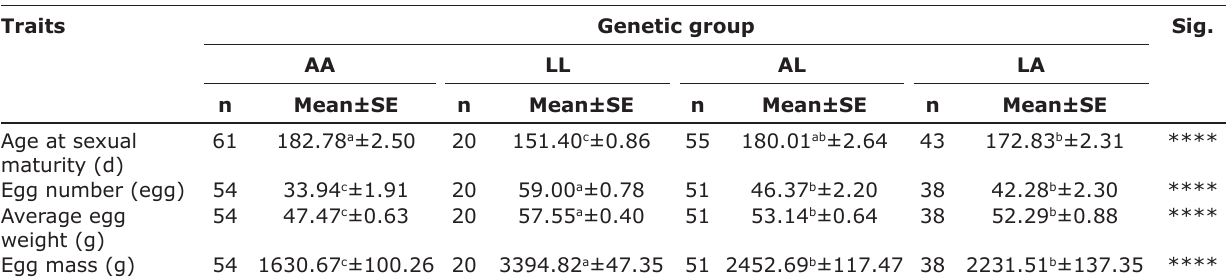
Table-2: Means and SE of egg traits by genetic group. Traits Genetic group Sig.